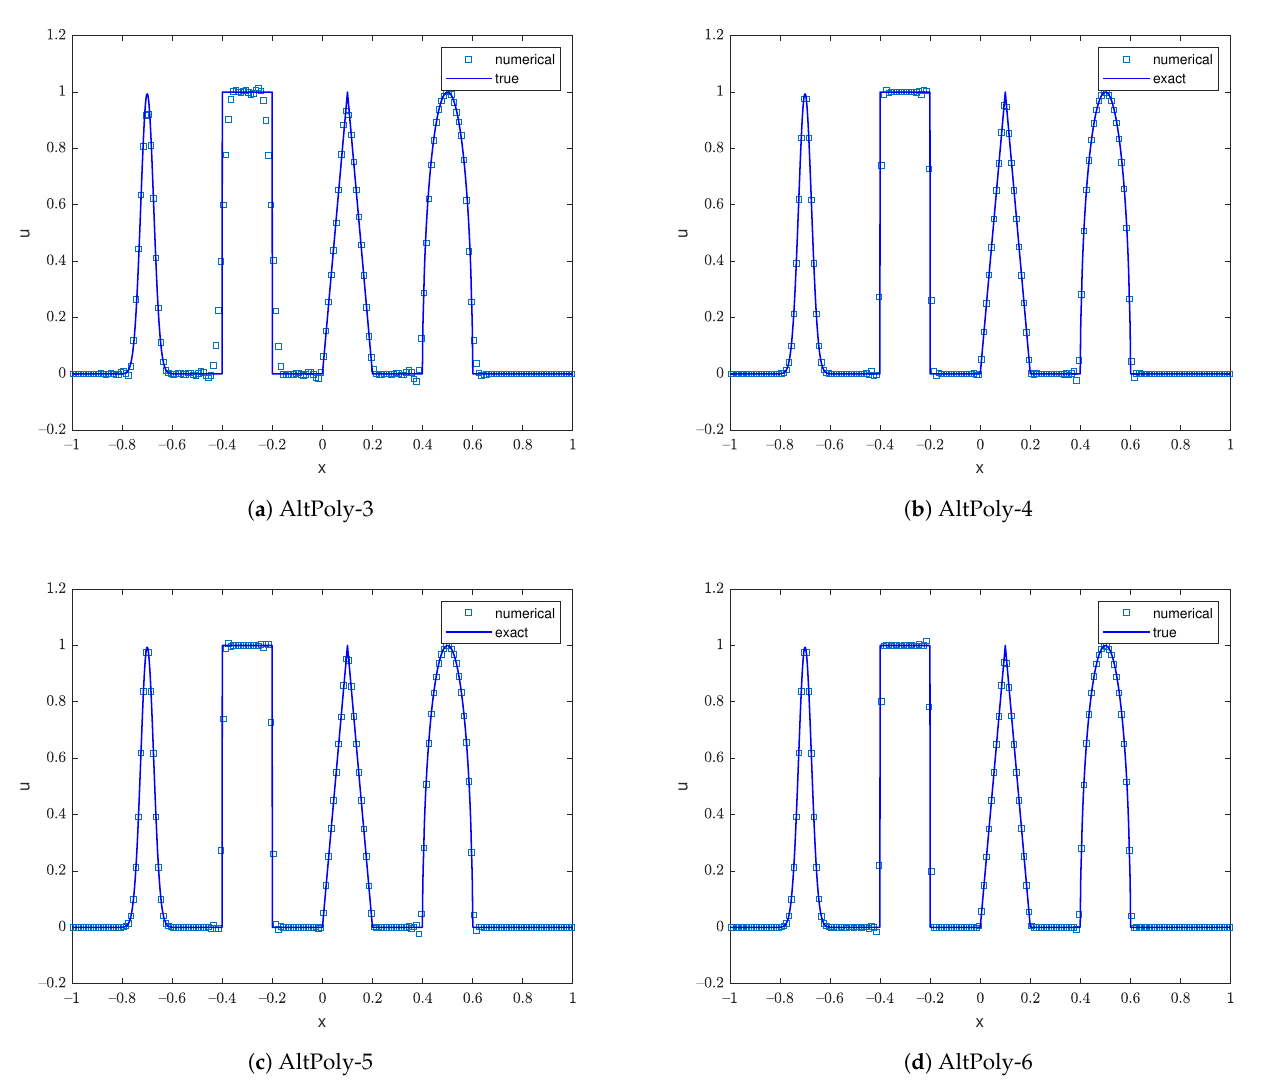
Figure 4. Numerical results of the advection of a complicated profile at t = 2 via AltPoly with artificial viscosity using N = 200